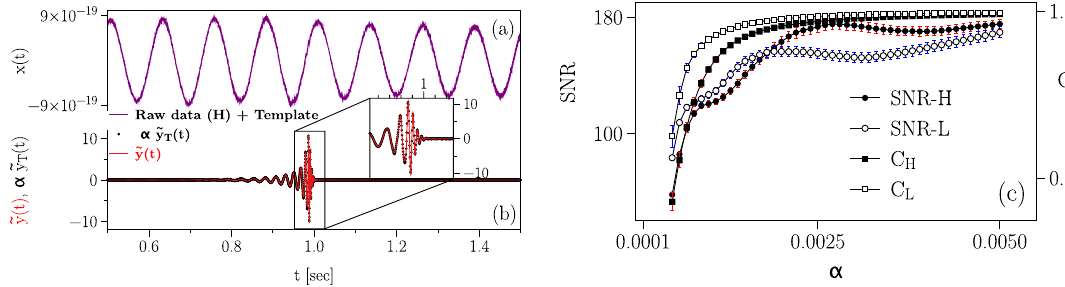
Figure 1. Extraction of injected signal into background noise with different signal to noise ratio (SNR). ( a ) Template of event on 14 September 2015 added to the raw data measured in the H-detector with α = 0.005 . ( b ) Extracted waveform and processed template are also shown. We find a very high similarity between extracted and processed waveforms. The correlation coefficient between two waveforms is ≃ 0.99 . The extracted waveform is in units of the standard deviation of the processed background noise. We applied our proposed steps to extract the injected template out of background noise. We called this an extracted waveform. Also we applied steps of our method only on the simulated template of GW150914 without adding it into background noise (which we called it processed template). ( c ) Signal to noise ratio (SNR) and cross correlation coefficients of extracted waveform with processed template for different α s. Error bars indicate the standard error of the mean averaged over 100 ensembles of background noise for each α . We did not preset the time of the injected waveform in 100 ensembles. In this paper SNR is defined as the ratio of extracted waveform and the mean value of processed background noise, ρ( i , j ) = |ˆ y ( i , j ) | 2 / E [|ˆ n ( i , j ) | 2 ] , summed over a certain frequency band. We note that due to the stochastic behavior of the background noise, different frequency bands in the spectrum will have effectively different SNRs in each time frame. Owing to the nature of our noise estimation approach, the noise will have a nonuniform effect on the SNR ratio of the extracted waveform specially when α is small 6 . However, as indicated in ( c ) when α increases, this effect will decrease and the relation between the SNR for the extracted waveform and the value of α becomes linear, with slops about 9300 and 5300 for L and H, respectively.